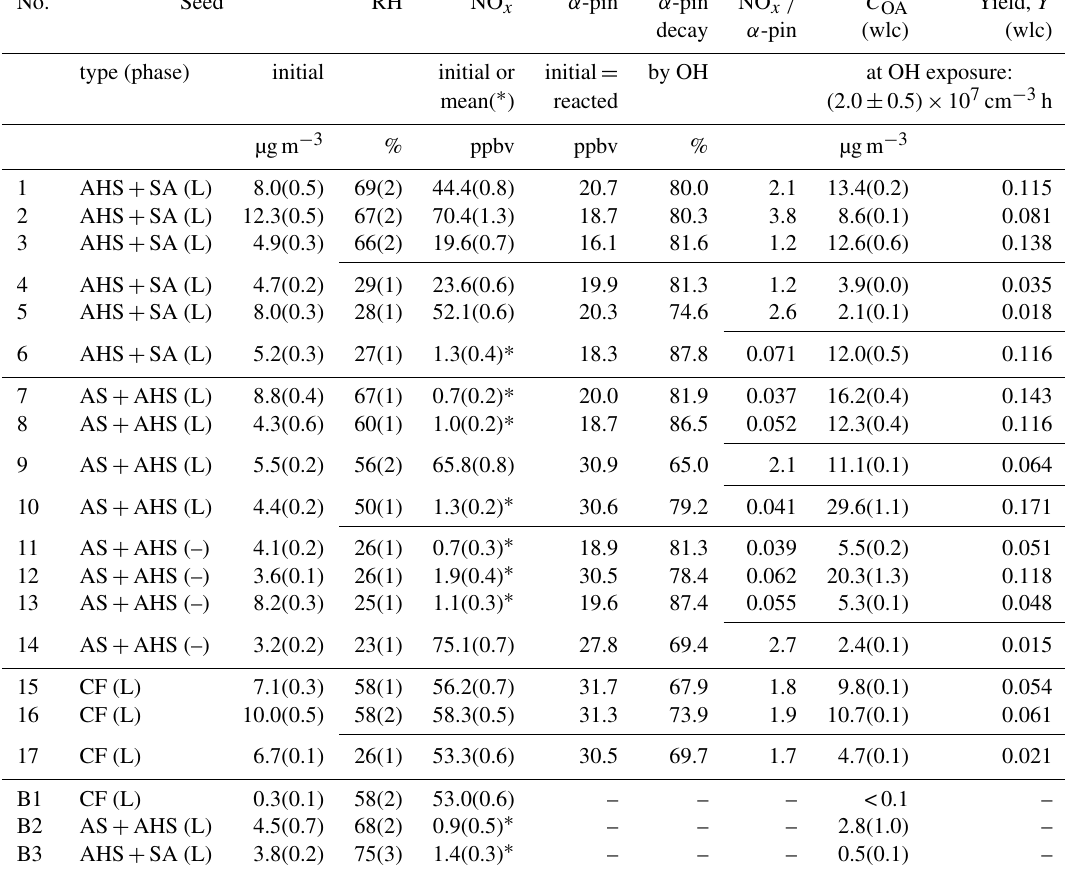
Table 1. Overview of experimental conditions. Seed types (AHS: ammonium hydrogen sulfate (NH 4 HSO 4 ) ; SA: sulfuric acid (H 2 SO 4 ) ; AS: ammonium sulfate ((NH 4 ) 2 SO 4 ) ; CF: fluorinated carbon (see Sect. 2.2)) and their assumed phase states: (L): liquid; (–): liquid and/or solid. Initial seed mass concentrations; relative humidity (RH); measured mean NO x concentrations during low NO x experiments (marked with an asterisk) and measured initial NO x concentrations during high NO x experiments; measured initial α -pinene concentrations (which reacted before an OH exposure of (2.0 ± 0.5) × 10 7 cm − 3 h) and their estimated fractions reacted with OH radicals in %; the rest reacted with O 3 ) . NO x /α -pinene ratios; wall-loss-corrected organic mass concentrations ( C OA ) and corresponding yields Y averaged over the OH exposure